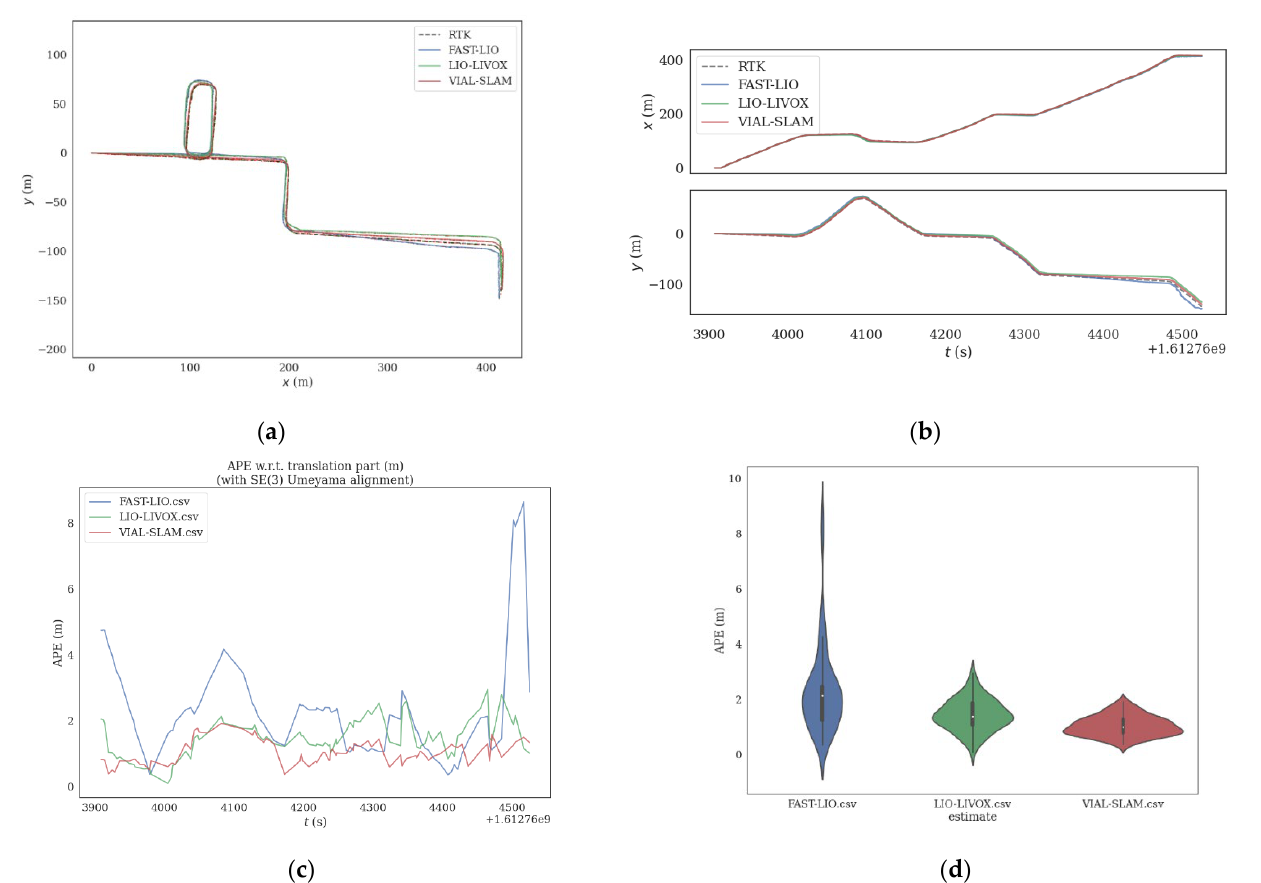
Figure 8. Error analysis diagram. ( a ) Trajectory comparison; ( b ) trajectory comparison on the x -axis and y -axis; ( c ) error comparison; ( d ) error estimate.